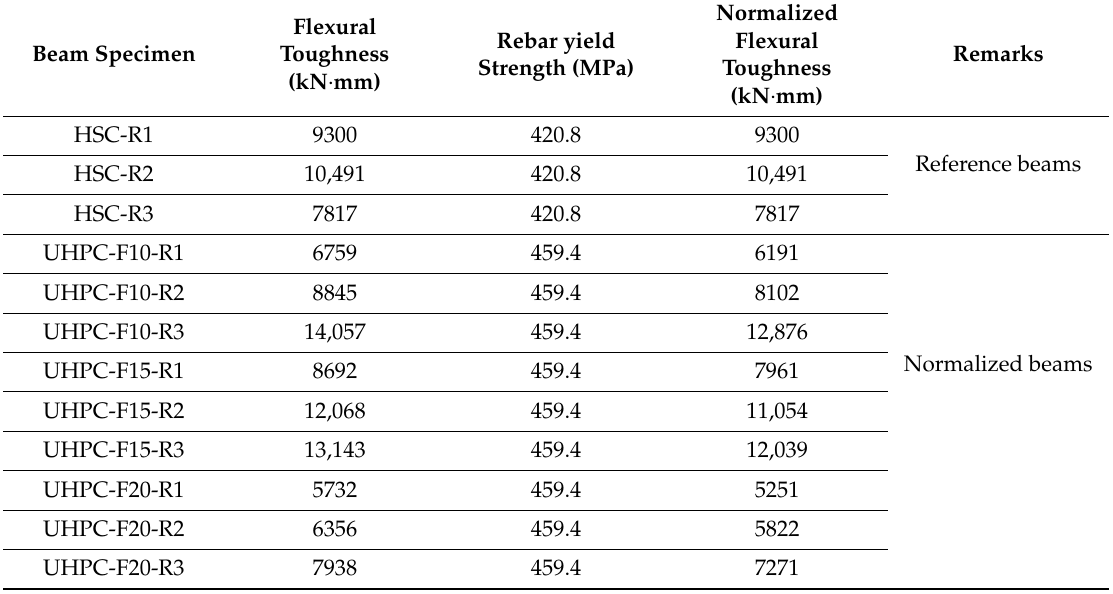
Table 5. Flexural toughness of the beams.